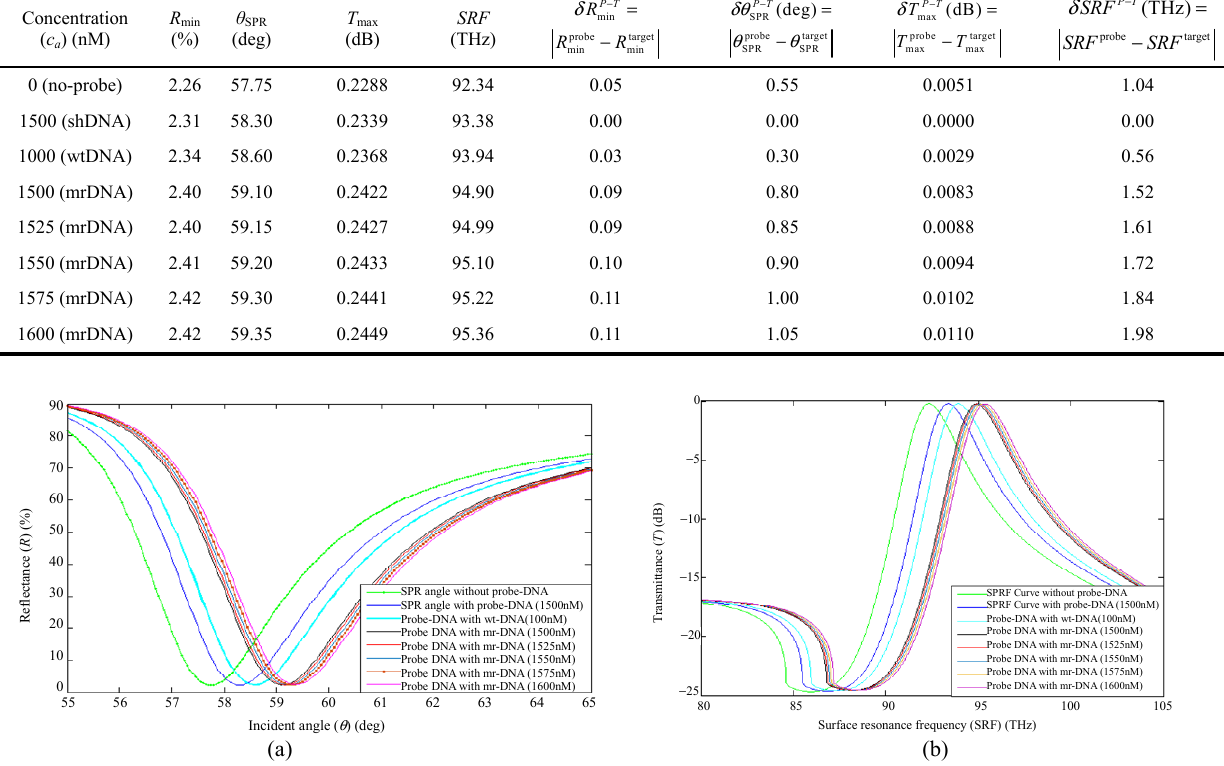
Fig. 5 Change in characteristics curves for (a) SPR curve characteristics and (b) SPRF curve characteristics of the SPR sensor without pDNA, with pDNA and, with flowing different concentrated complementary target mrDNAs or mismatched target wtDNAs of BRCA1 and BRCA2 genes with PBS